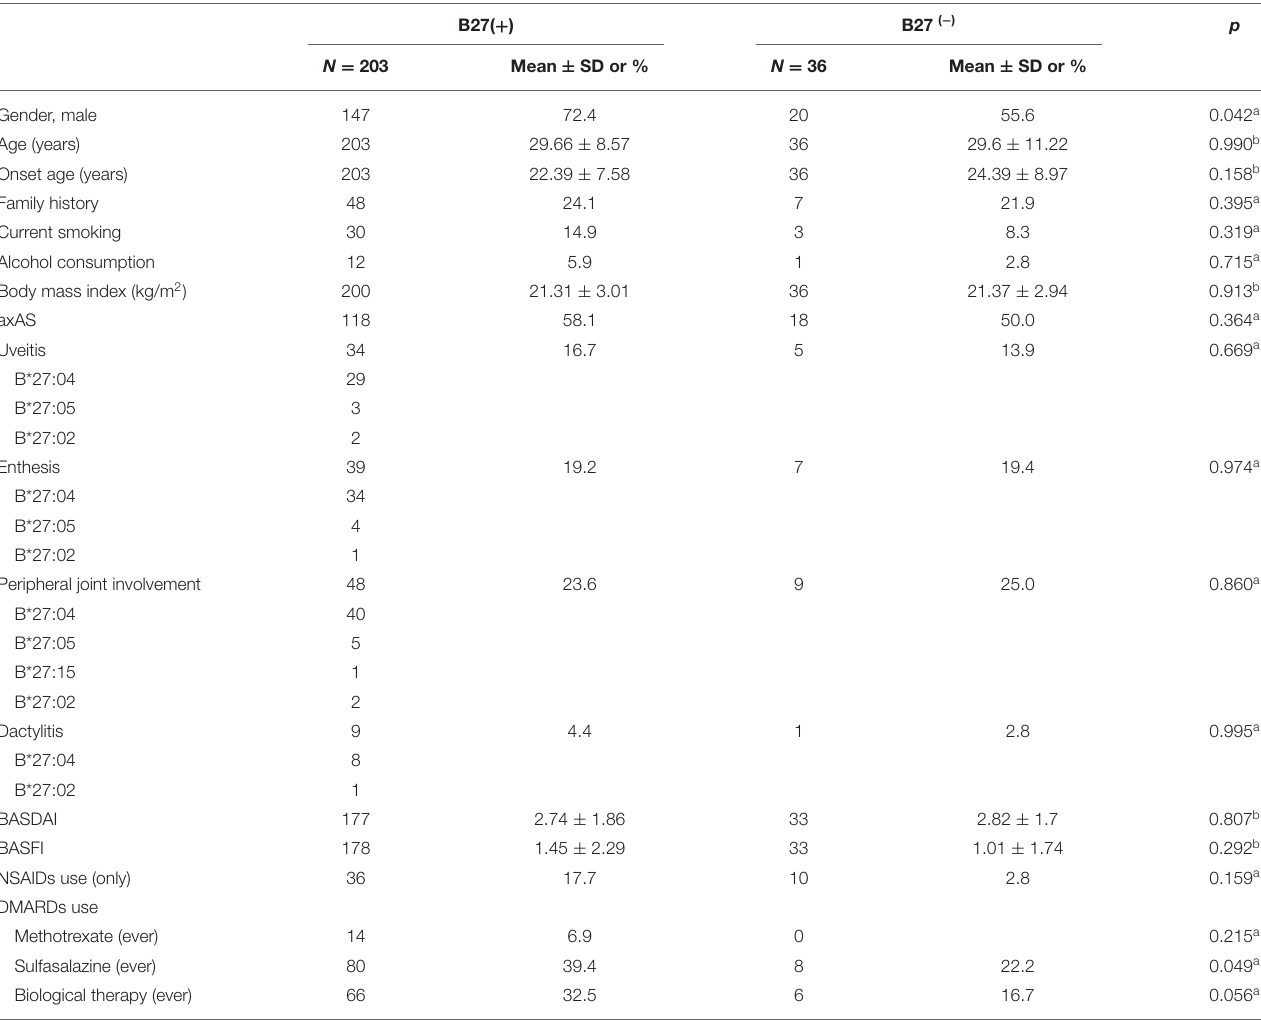
TABLE 3 | Demographic and disease characteristics of the B27( + ) and B27( − ) AS patients (step 2). B27( + ) B27 ( − ) p N = 203 Mean ± SD or % N = 36 Mean ± SD or % Gender, male